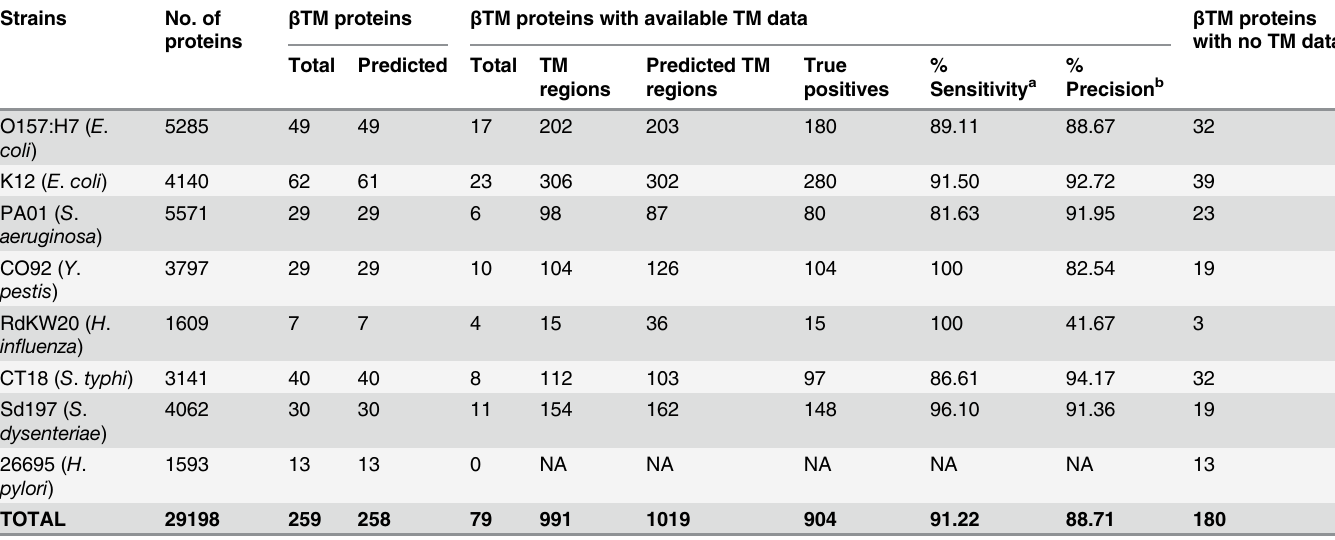
The outer-membrane proteins with known transmembrane β -strands are analyzed in detail to obtain the prediction sensitivity and precision. a Sensitivity: TP/(TP+FN), % of all observed transmembrane β -strands predicted correctly by the model. b Precision: TP/(TP+FP), % of all predicted transmembrane β -strands that are correctly predicted.